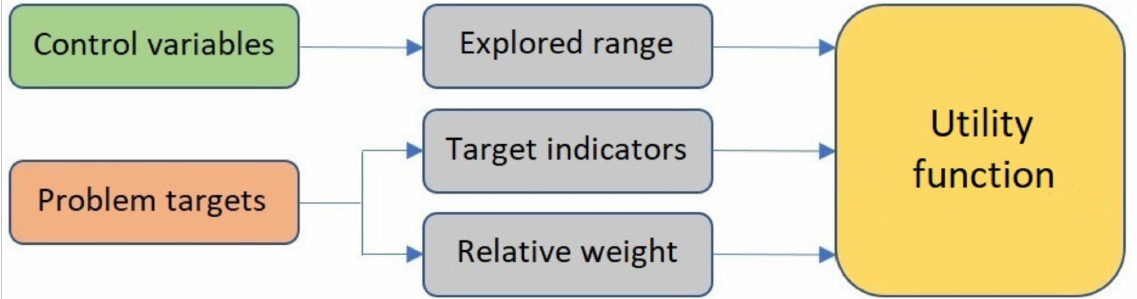
Figure 4. Definition of utility function for the multi-objective